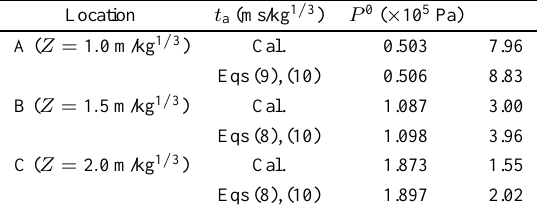
Comparison of calculations and analytic results of overpressure in air